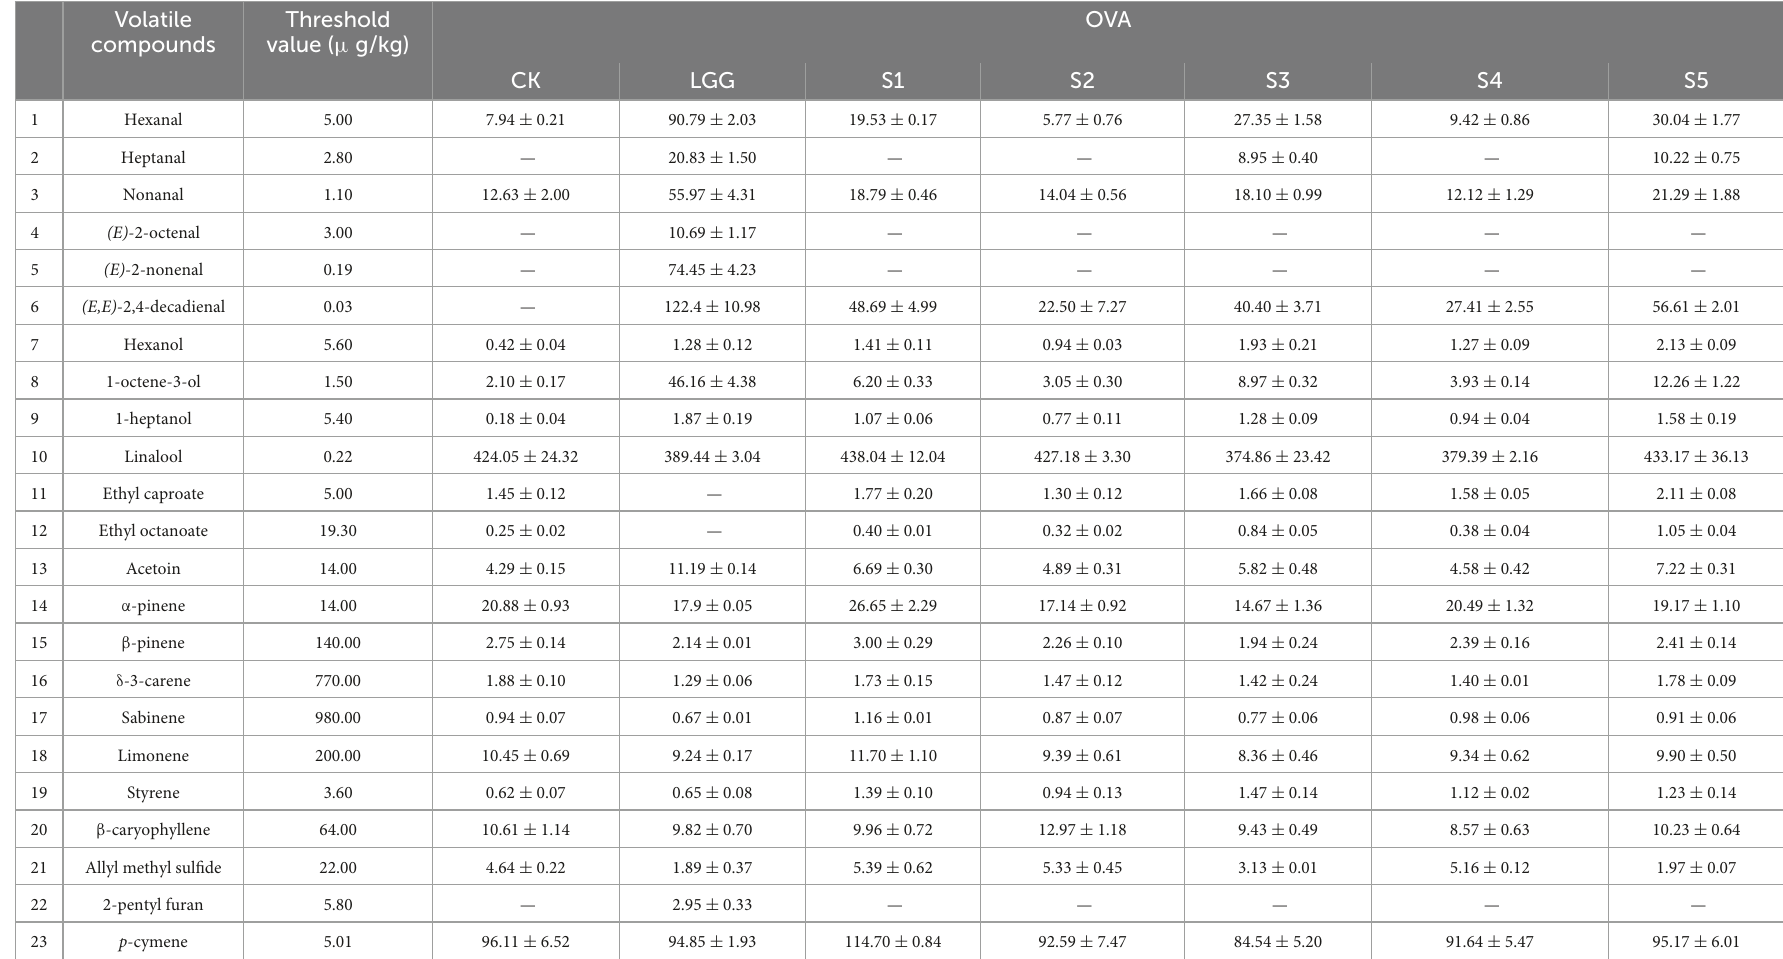
TABLE 3 Changes of key volatile flavor compounds OAV in different fermented sausage